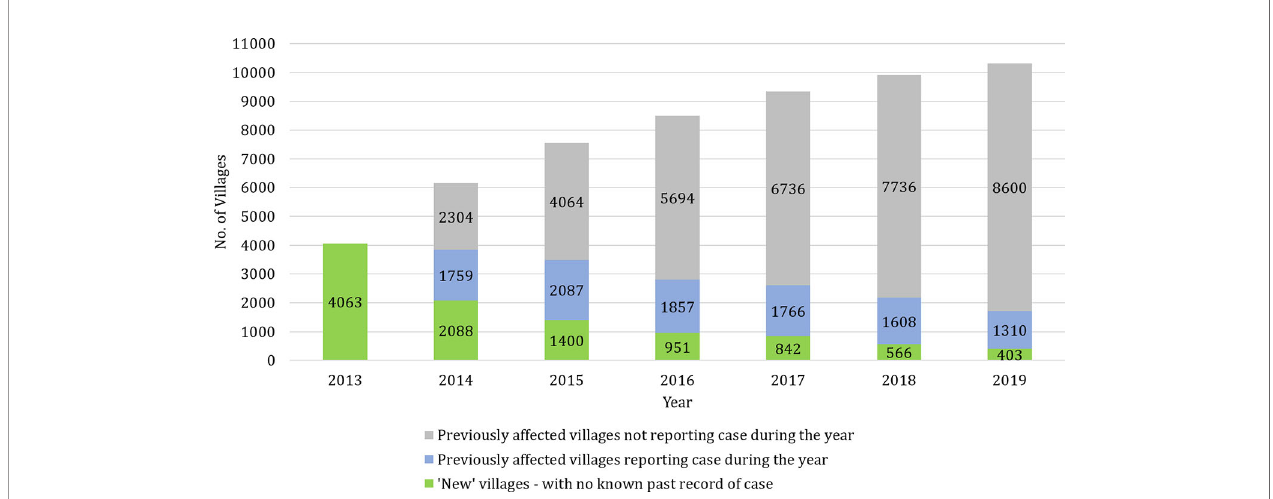
FIGURE 1 | Occurrence of visceral leishmaniasis cases in previously affected and unaffected villages each year. The stacked bars show the number of ‘ new ’ villages and ‘ previously affected ’ villages with and without cases from 2013 to 2019. Since no village-level VL case data were available prior to 2013, all affected villages that year are considered to be ‘ new ’